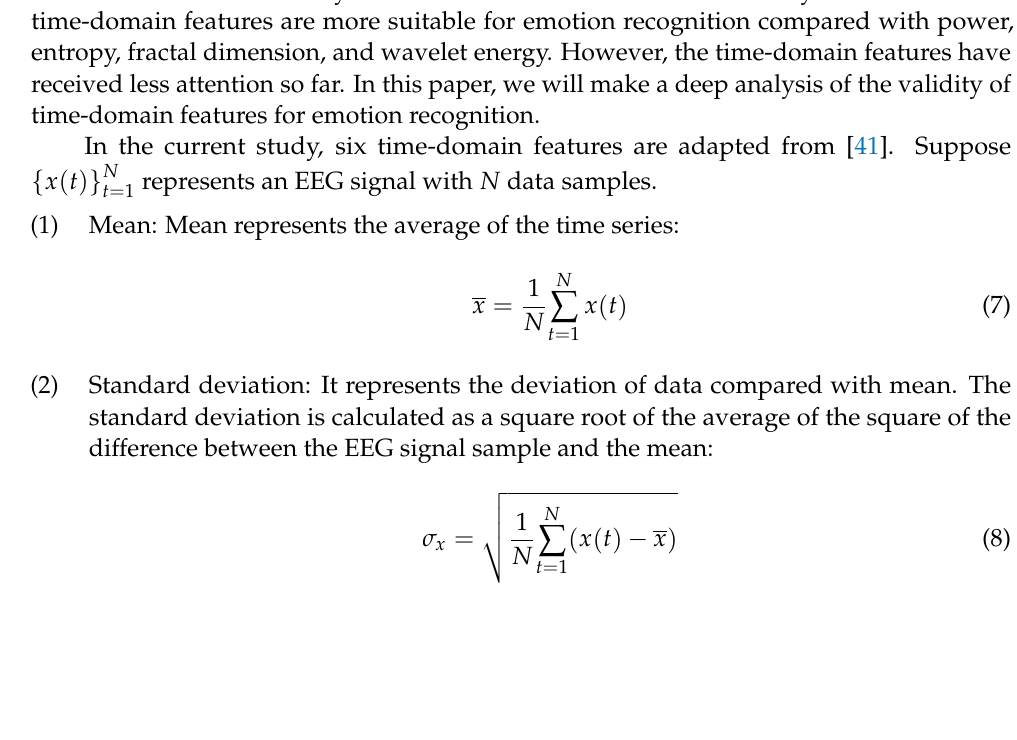
Standard deviation: It represents the deviation of data compared with mean. The standard deviation is calculated as a square root of the average of the square of the difference between the EEG signal sample and the